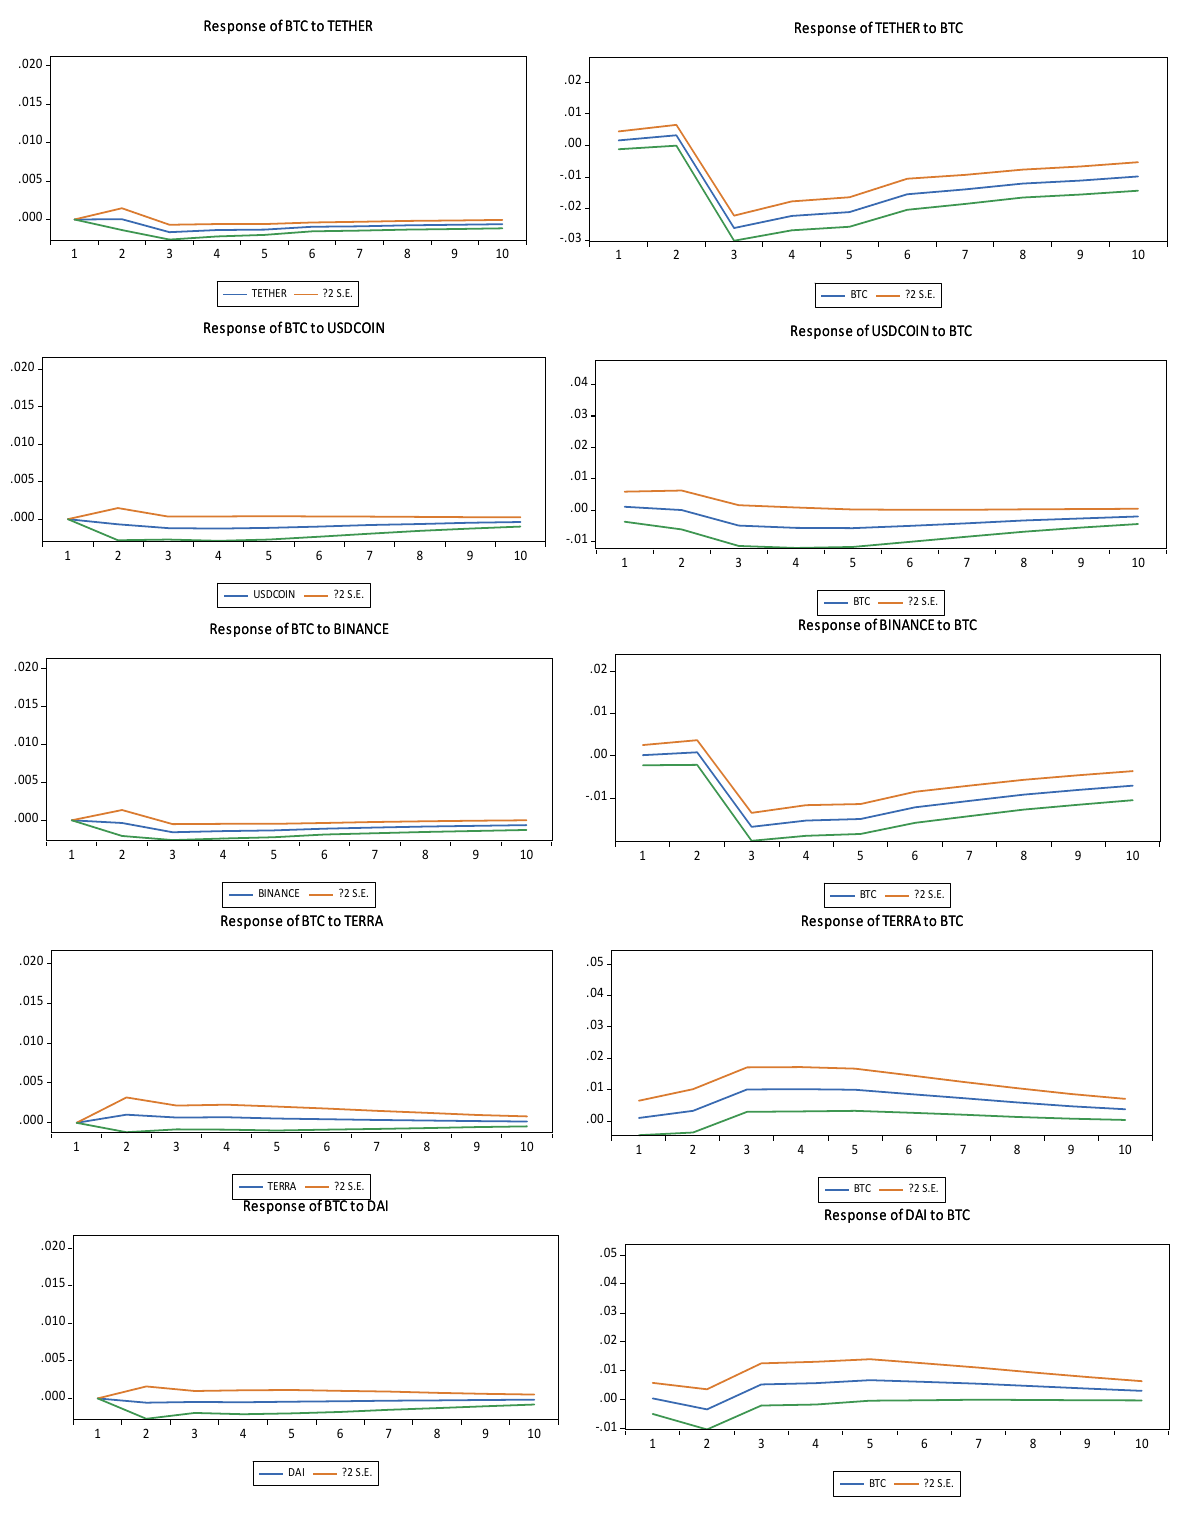
Figure 7. VAR impulse responses of the Bitcoin to stablecoins by subperiod 2 (post-13 March 2021).